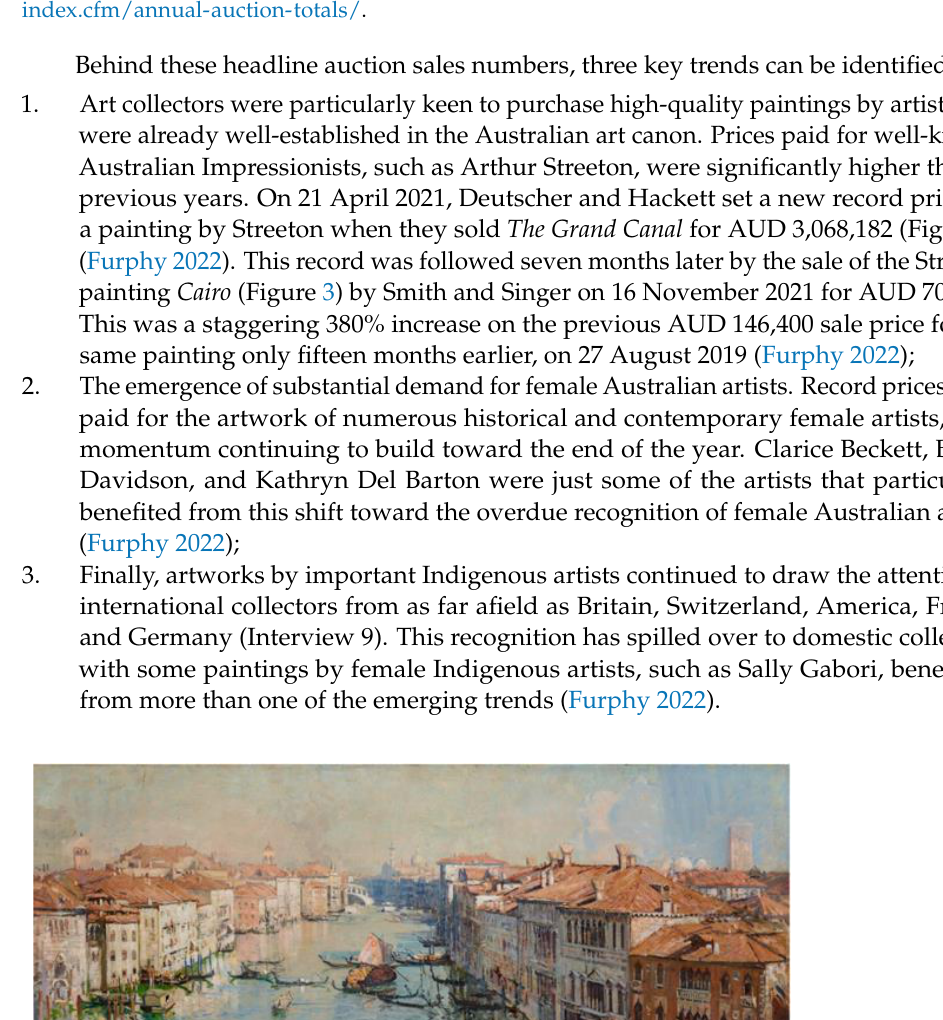
Figure 2. Arthur Streeton, The Grand Canal , 1908, oil on canvas, 92 × 168.5 cm.